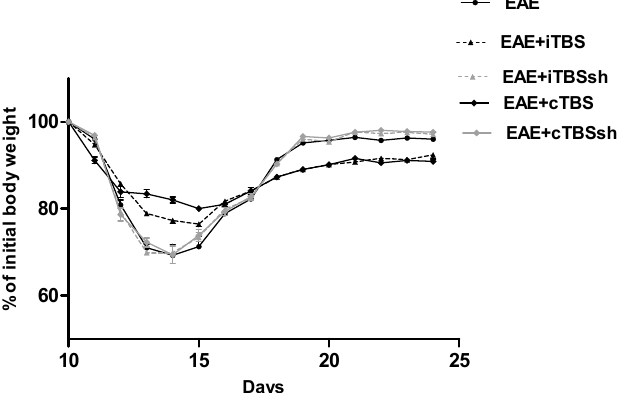
Figure 1. The effect of EAE, i/cTBS, and sham i/cTBS on the rat body mass. The average values of body mass changes per group were presented linearly and are expressed as a percentage of initial body